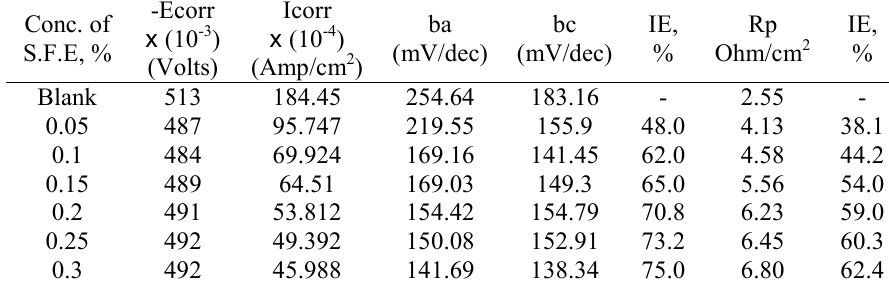
Table 3. Electrochemical data by Linear and Tafel polarization for corrosion of MS in the presence of SFCN extract in HCl.